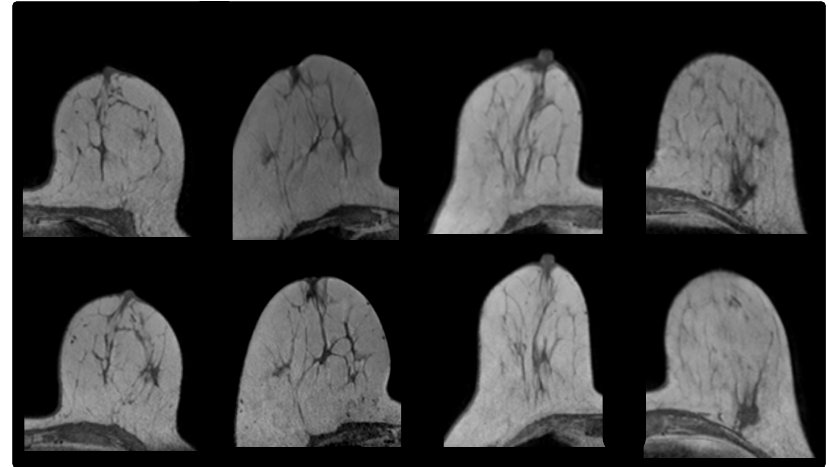
Figure 1. From ( left ) to ( right ): prone-prone Cases 3, 6, 8, 9. ( Upper ) row: MR image acquired before radiotherapy. ( Lower ) row: MR image acquired after